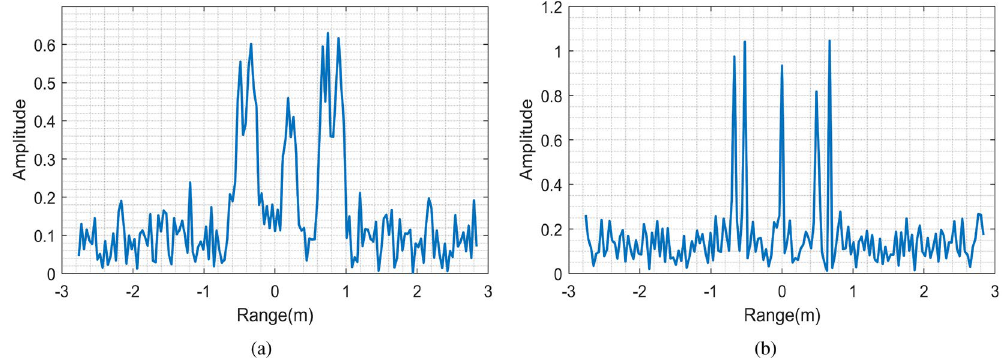
Figure 4. Comparison of range profiles. ( a ) Range profile before compensation. ( b ) Compensation for range profile broadening.